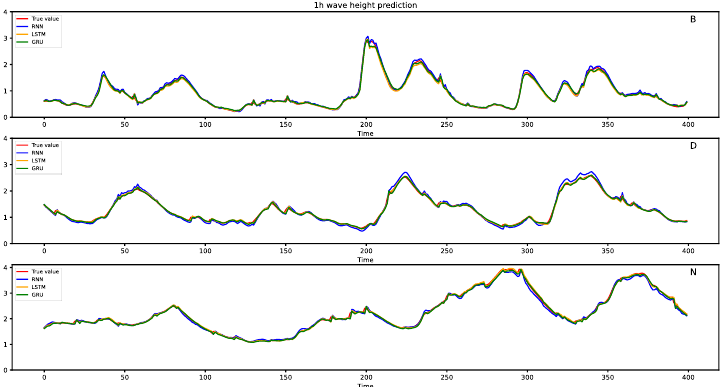
Figure 7. One-hour forecast results; the abscissa represents the time, the ordinate represents the wave height, the red line represents the real wave height, the blue represents the predicted value of the RNN, the yellow represents the predicted value of LSTM, and the green represents the predicted value of GRU.